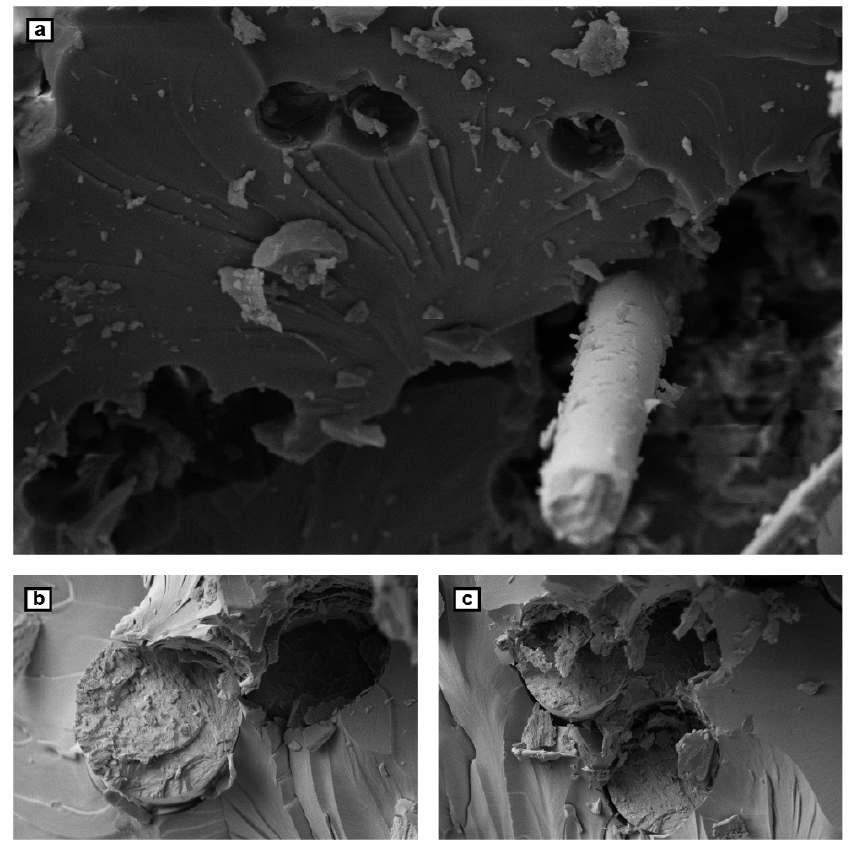
Figure 3. SEM images of the fractured surface of the tensile-tested samples: ( a ) the failure surface of unmodified epoxy composites; ( b , c ) the surface of the developed nanocomposites.